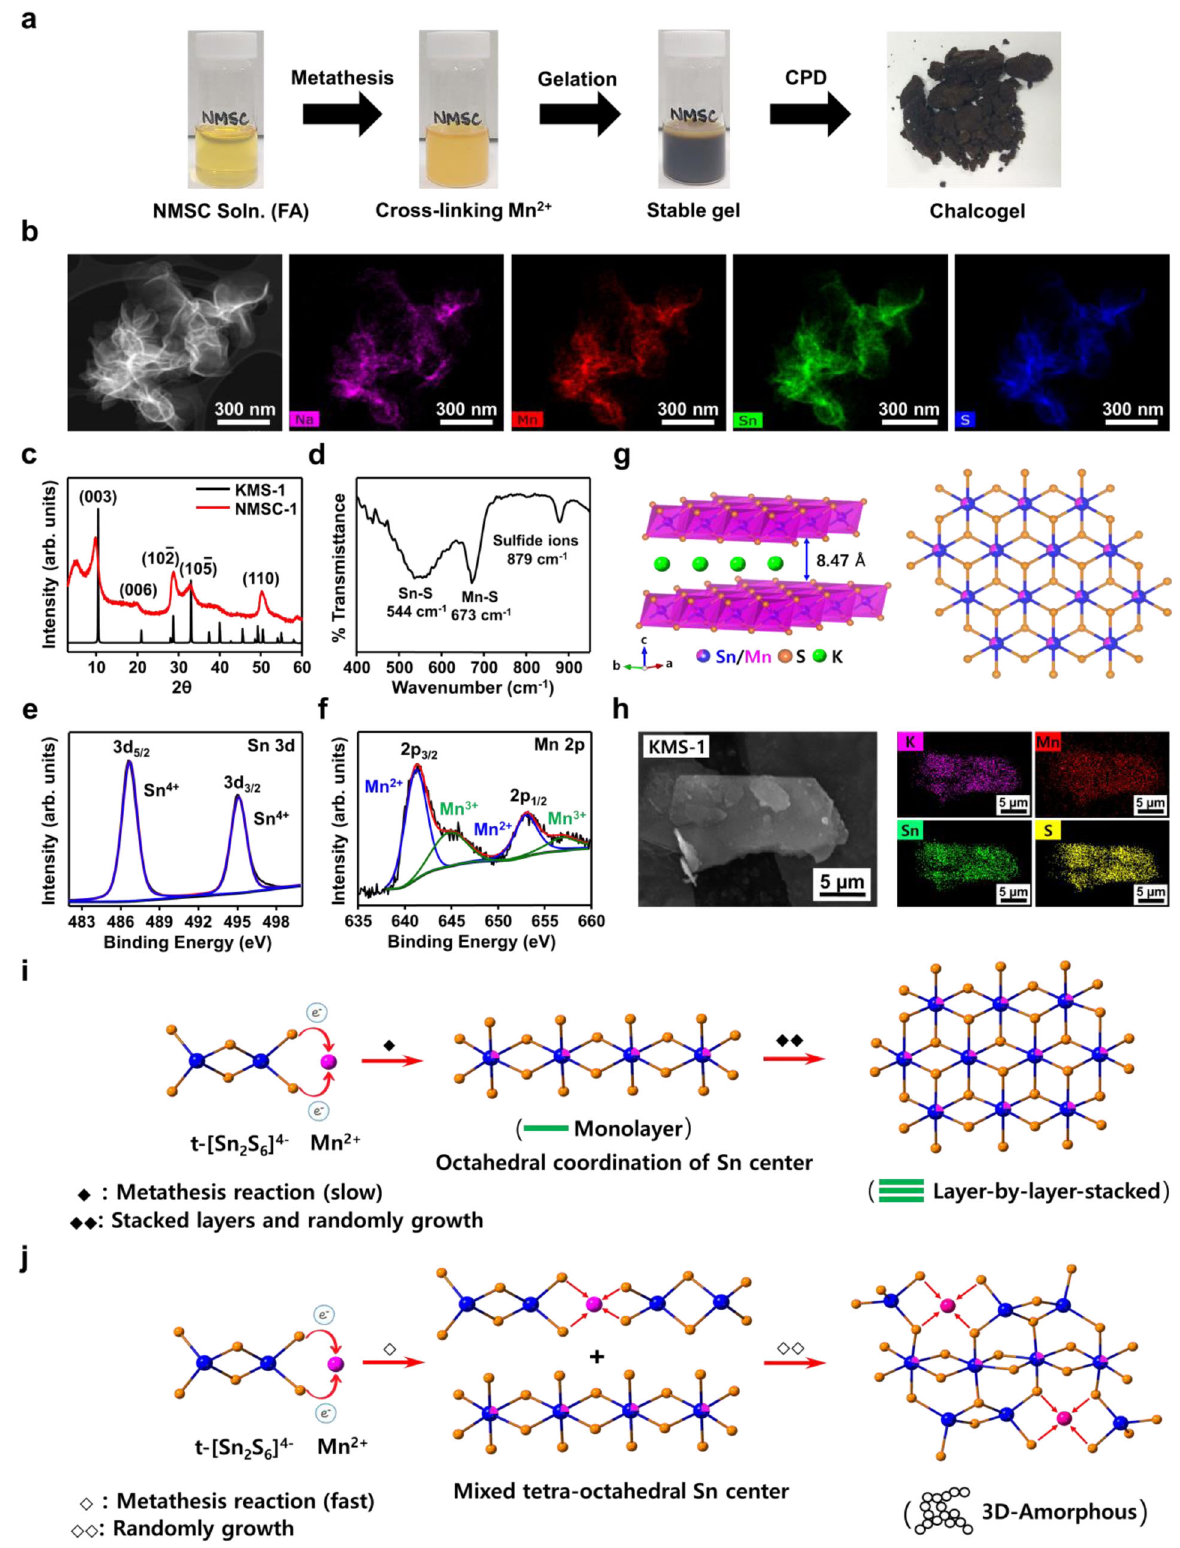
Fig. 1 | Synthesis, characterization, and hypothesized mechanism of coordi- nation (Tetrahedral-Octahedral)-structure (Layer – Amorphous) switching of sodium manganese sul fi de chalcogel (NMSC) with a layered structure similar to that of metal sul fi de (KMS-1) materials. a NMSC synthesis. b EDS mapping of layered NMSC-1, including Na, Mn, Sn, and S. c – f Structural analyses of NMSC-1